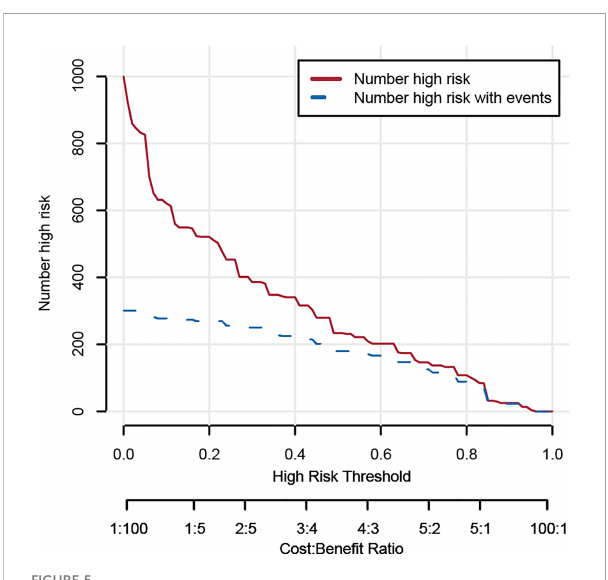
FIGURE 5 Clinical impact curve of the developed nomogram